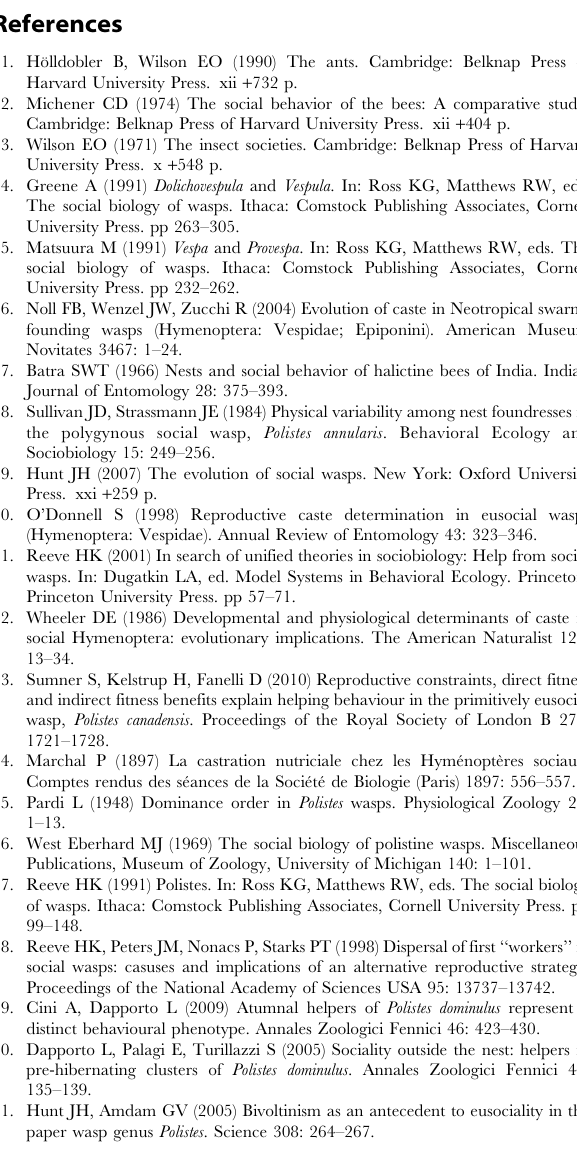
Table S5 Peptides/proteins used in the MWU-test. Criteria for using a peptide/protein: spectrum count of at least 3 present for at least 3 out of 5 replicates. N= 5 samples per group. Note that the table contains redundant data. Peptides can match to different databases (Apis, Nasonia, Polistes contigs) and isoform sequences. Also, two different kinds of experiments were run. Several contigs can belong to the same protein. For some contigs peptides matched to more than one reading frame (can be distinguished by the Accession number). Red font = results from in-solution digestion. Black font = results from in-gel digestion. p-value = bootstrap analysis (1000 iterations) verified validity, i.e. probability of Type I error is not inflated by multiple